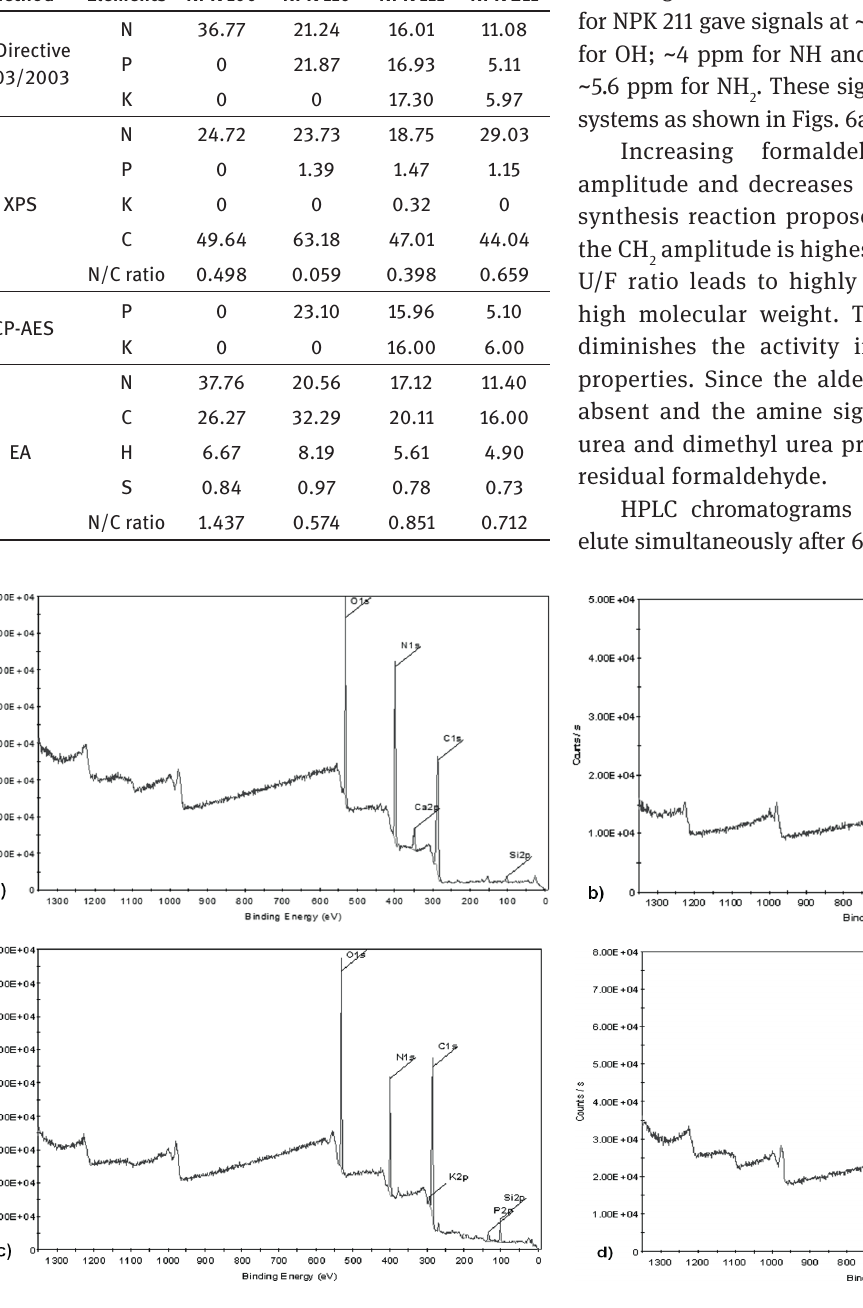
Figure 5: XPS analyses of a) NPK 100; b) NPK 110; c) NPK 111; d) NPK